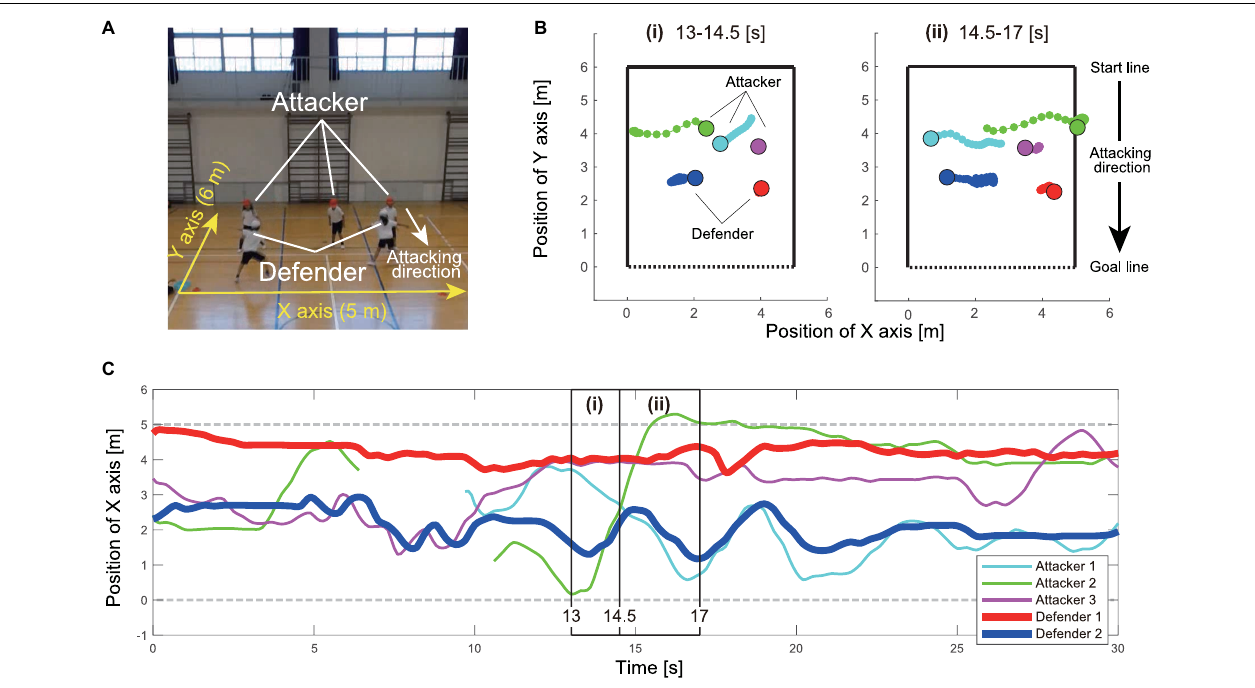
FIGURE 2 | Examples of recording and analysis of physical tasks. Panel (A) illustrates a part of the recording view for the physical task, 3-on-2 tag game, and the definition of the X-Y axis. Panel (B) provides examples of movements of two defenders (red and blue) and three attackers (cyan, green, and magenta) on the court corresponding to the two boxes (i,ii) in panel (C) . Panel (C) shows the time series in the position of the X-axis for the two defenders and three attackers. The red and blue bolded lines represent the two defenders and the cyan, green, and magenta shin lines represent the three attackers. The time when the shin line is broken is when the attacker reaches the goal line or is touched by the defender. The distance between the red and blue lines is calculated as